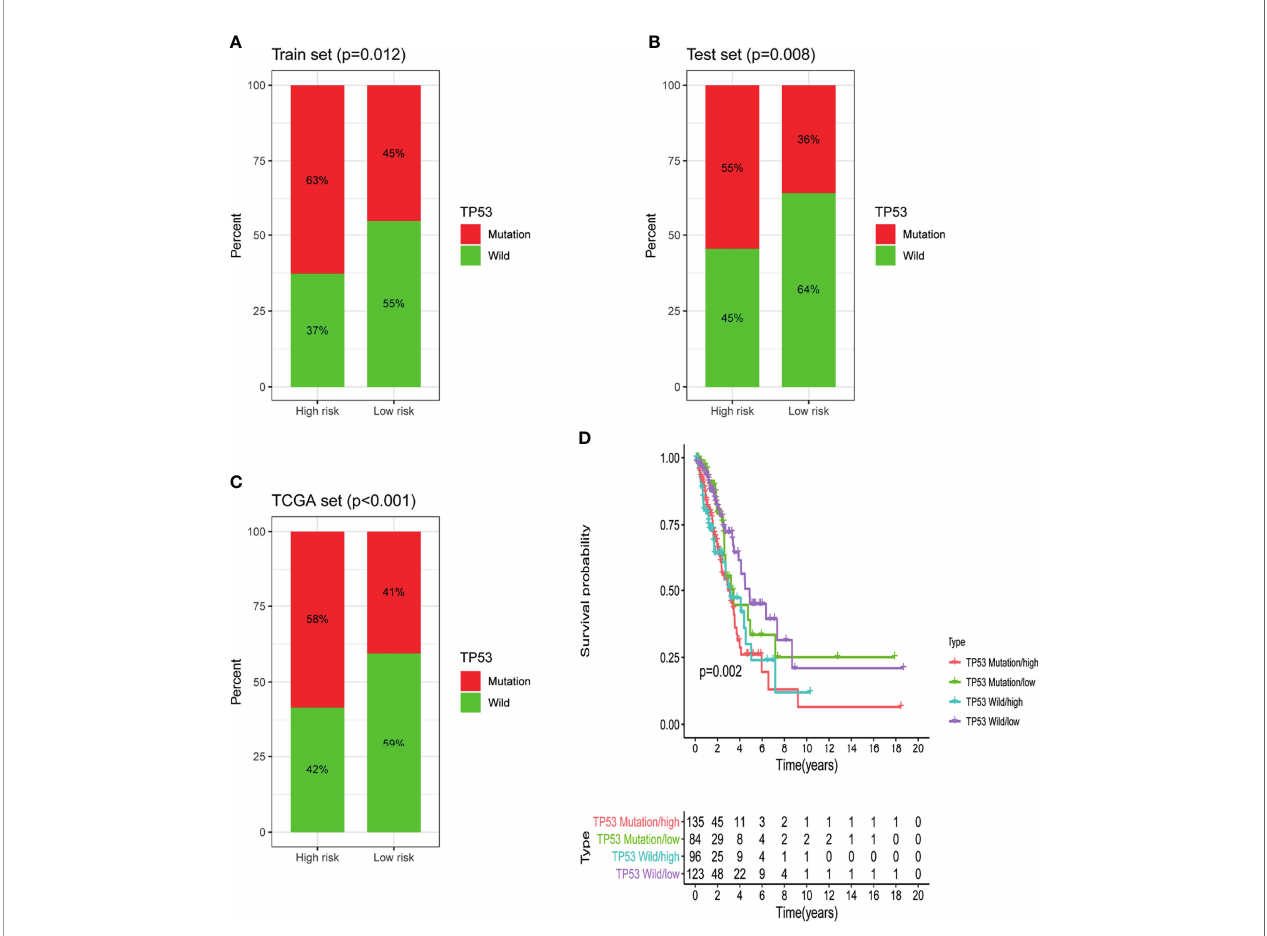
FIGURE 7 | Identi fi cation of the relationship between TP53 somatic mutation and GILncSig. (A) Comparison of the mutation ratio of TP53 in the high-risk and low- risk groups in the training set. (B) Comparison of the mutation ratio of TP53 in the high-risk and low-risk groups in the testing set. (C) Comparison of the mutation ratio of TP53 in the high-risk and low-risk groups in the TCGA set. (D) Survival analysis of LUAD patients was categorized on the basis of the GILncSig and the TP53 mutation